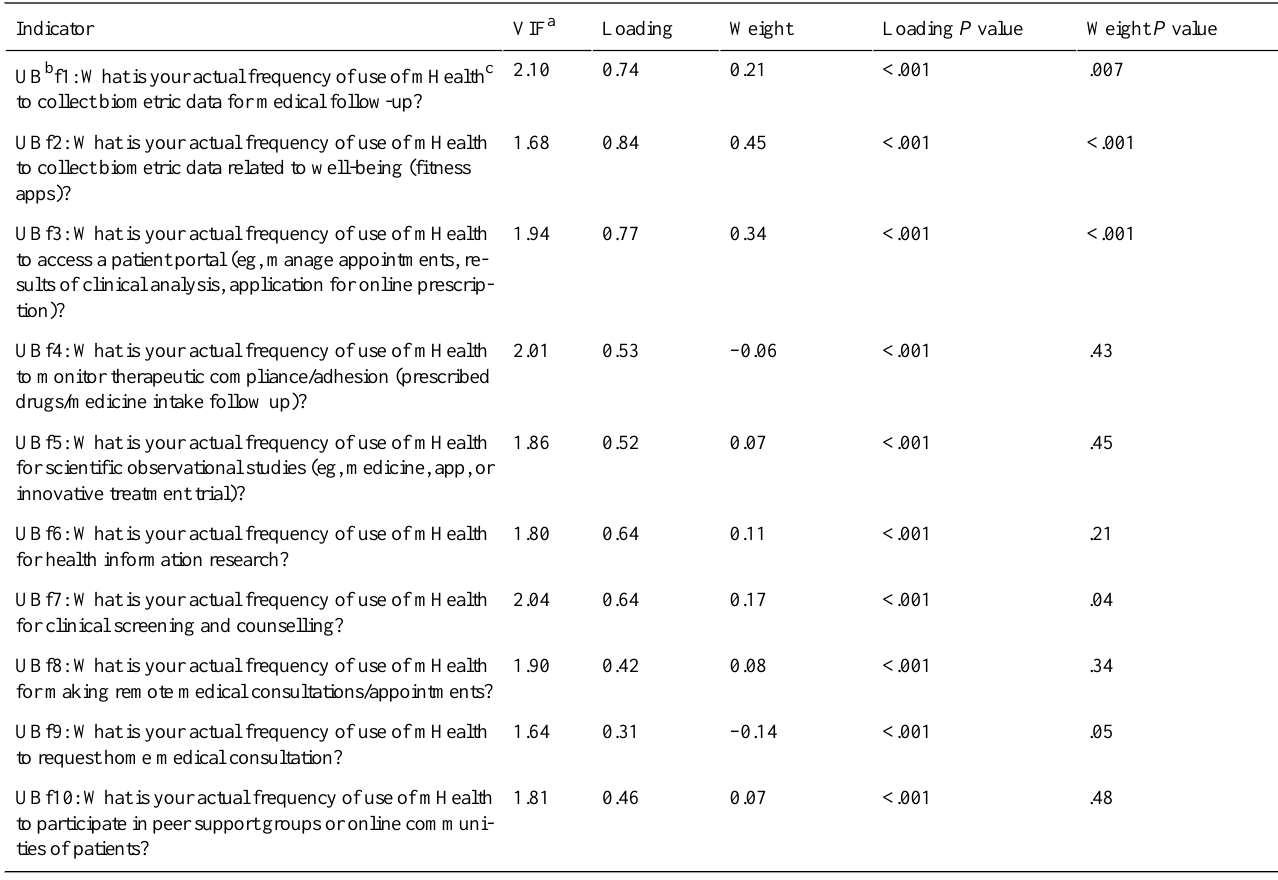
Table 5. Formative indicators for quality criteria.